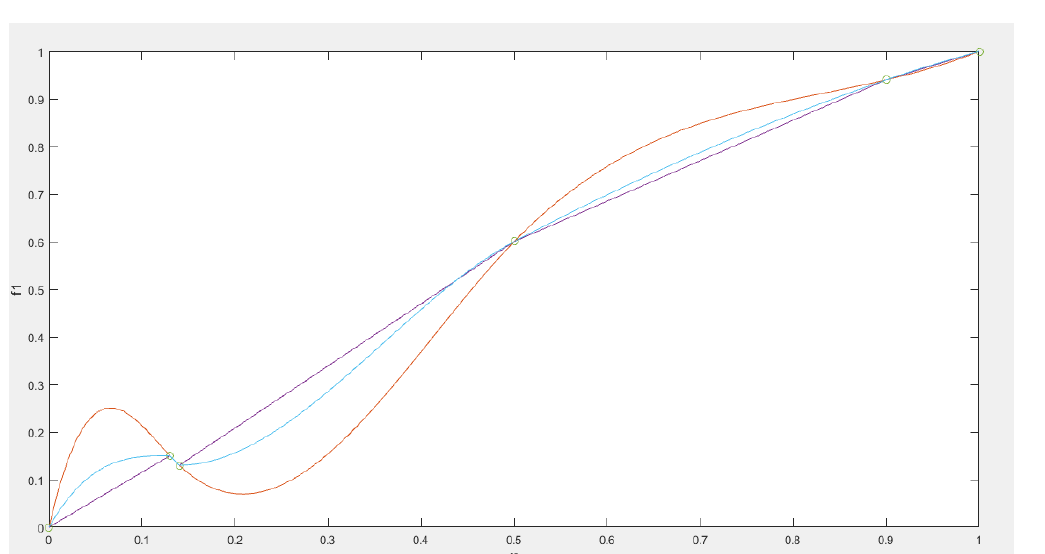
Figure 4. Piecewise cubic homotopy (orange color), Shape-preserving piecewise cubic homotopy (blue color) and linear homotopy (purple color) for a set of